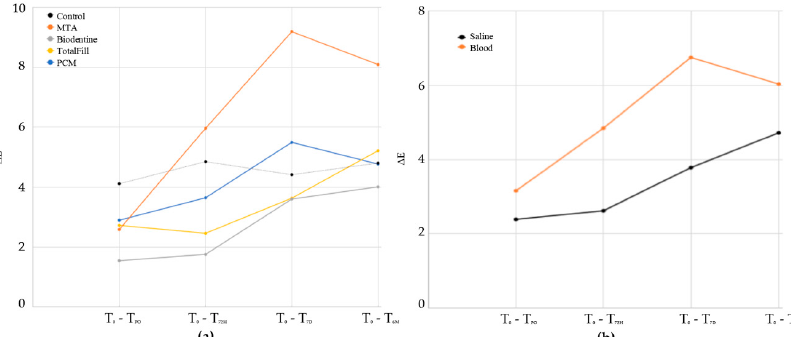
Figure 4. Color variation ( Δ E) over time considering only the ( a ) materials (mineral trioxide aggregate (MTA), Biodentine, TotalFill, and PCM) and ( b ) treatment (Saline and Blood) variation.